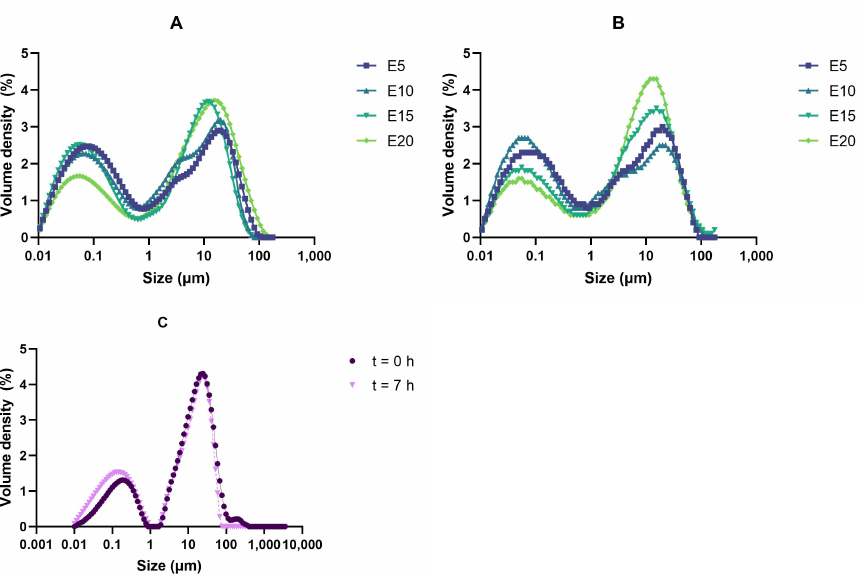
Figure 3. Volume density of particle size in PPI emulsions at ( A ) t = 0 h, ( B ) t = 7 h, and ( C ) PPI suspensions without oil (E0) after storage at room temperature. Sample name corresponds to its oil content, e.g., E0: 0% oil, E5: 5% oil,